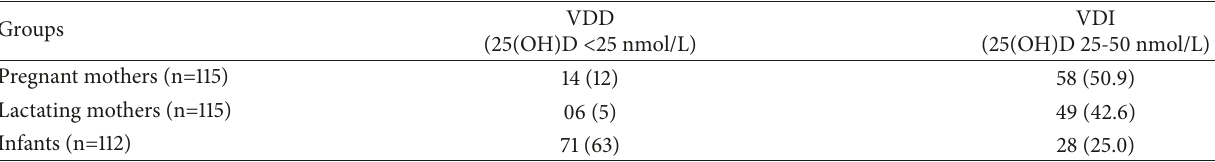
Table 2: Low 25 (OH)D levels in pregnant/lactating mother and infants.